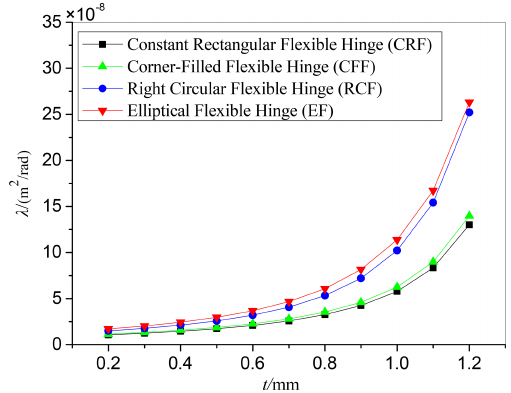
Figure 3. Relationship between λ and varied t .